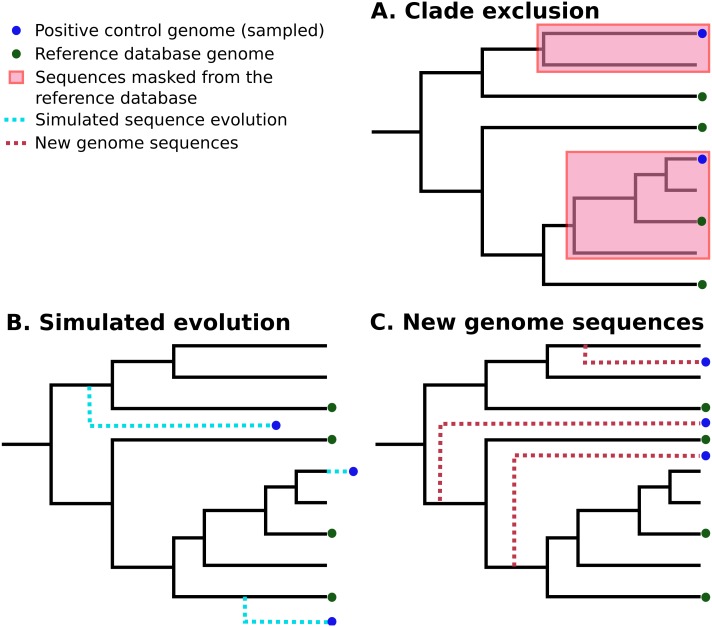
Three different strategies for generating positive control sequencing datasets.Three different strategies for generating positive control sequencing datasets, i.e., genome/barcoding datasets of known taxonomic placement that are absent from existing reference databases. These are: (A) “clade exclusion”, where positive control sequences are selectively removed from reference databases (Peabody et al., 2015); (B) “simulated evolution”, where models of sequence evolution are used to generate sequences of defined divergence times from any ancestral sequence or location on a phylogenetic tree e.g., (Stoye, Evers & Meyer, 1998; Dalquen et al., 2012); and (C) “new genome sequences” are genome sequences that have been deposited in sequence archives prior to the generation of any reference sequence database used by analysis tools (Sczyrba et al., 2017) .